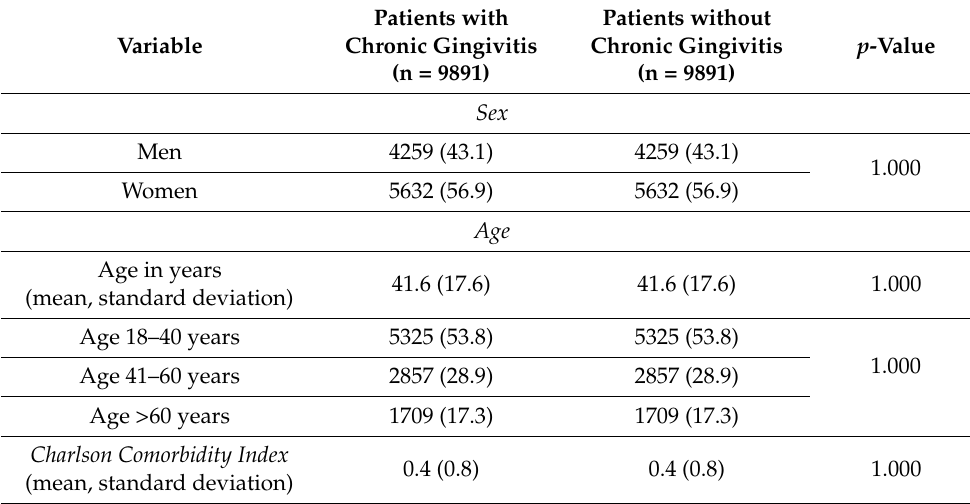
Table 1. Baseline characteristics of study patients after 1:1 matching.